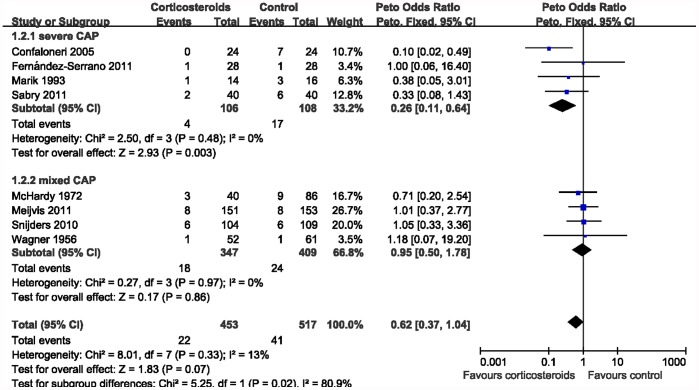
Subgroup analysis according to the severity of CAP.